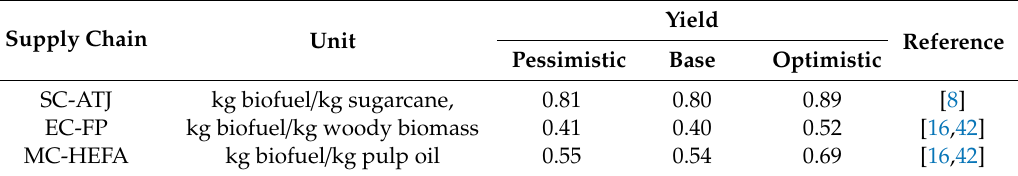
Table 3. Sensitivity analysis ranges of biofuel conversion